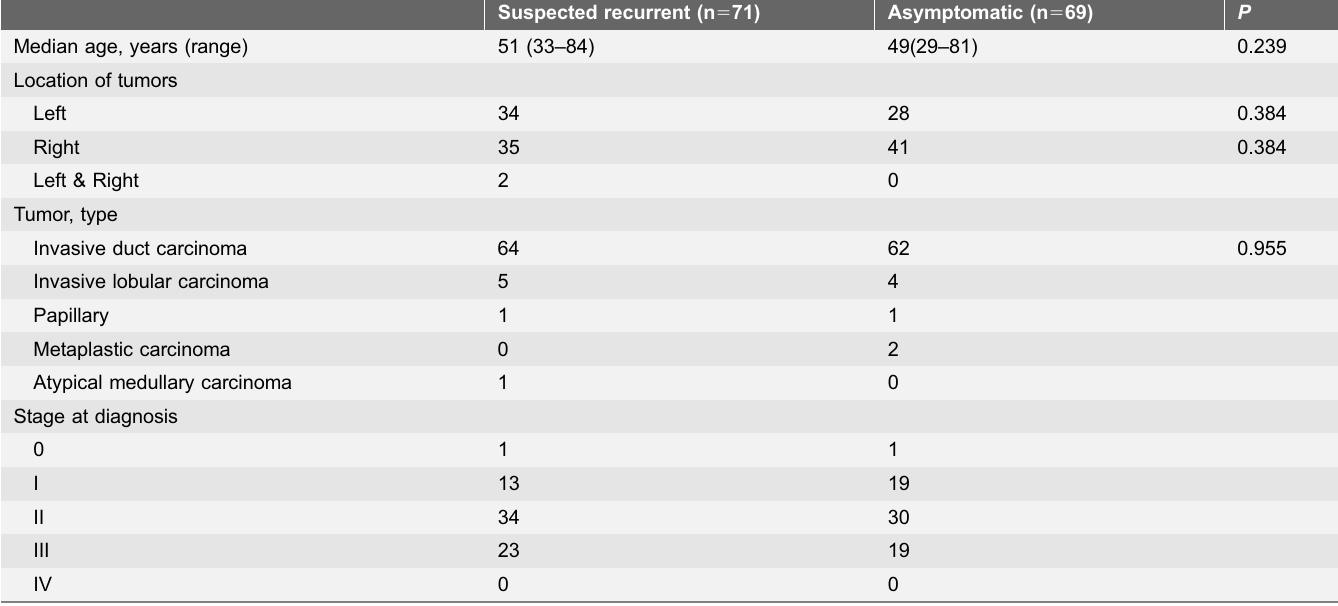
Table 1. Patient